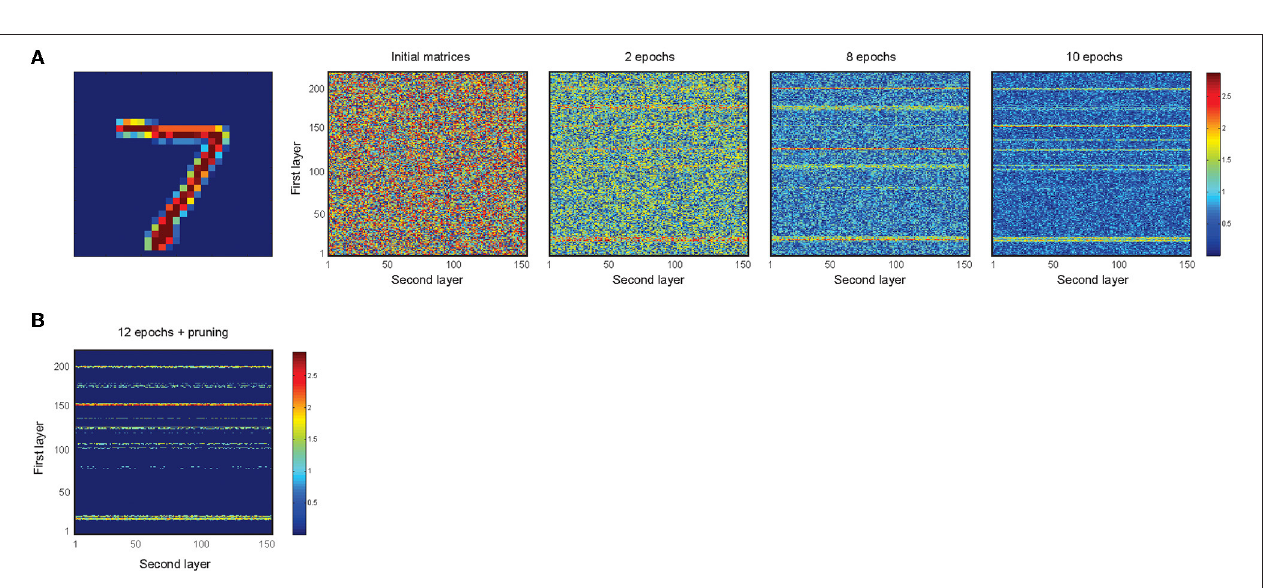
FIGURE 6 | Training of the network for 4 samples of digit class “7” using the learning rule and synaptic pruning. (A) The random synaptic weights between the first and second layers are changed according to the learning rule for different epoch numbers of image presentation. Increase in the epoch number leads to gradual changes in the synaptic weights between the activated neurons in the first and second layers. (B) A pruning threshold (here 0.8) is used to set weak synapses to 0 such that strong connections of neurons that represent the features of an image are